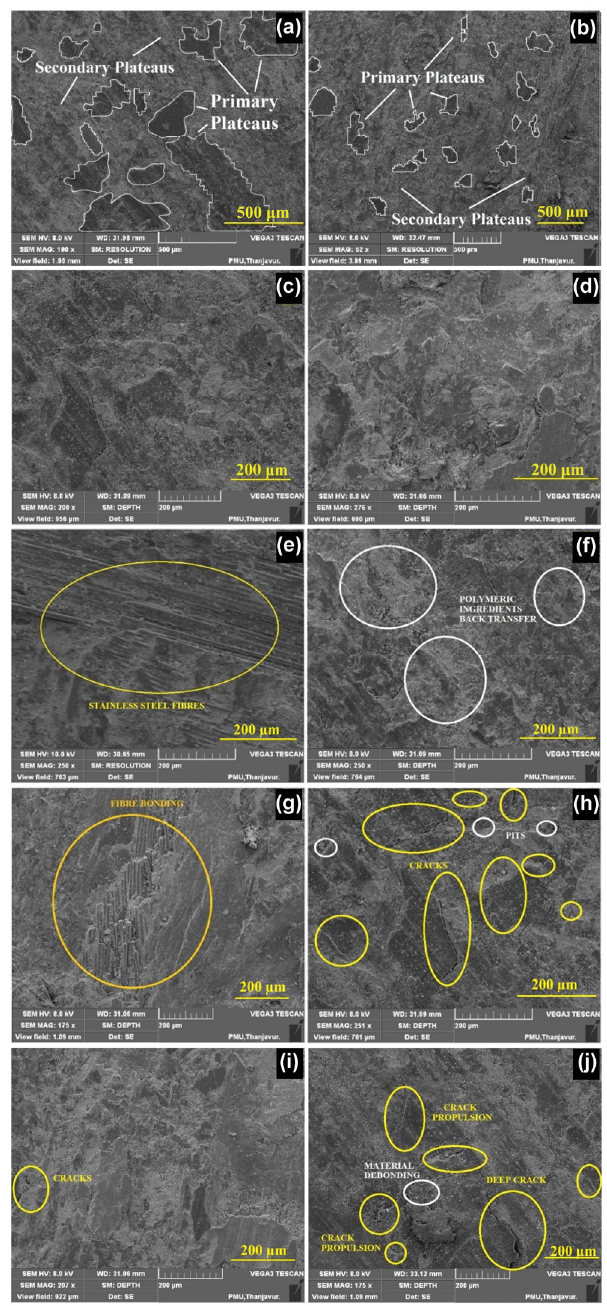
Fig. 11 SEM images of (a) plateaus formation of the FM02 dyno tested composites, (b) plateaus formation of the FM01 dyno tested composites, (c) plateaus formation of the FM02 dyno tested composites closure view, (d) plateaus formation of the FM01 dyno tested composites closure view, (e) fibers in the direction of sliding of the FM02 composite, (f) more back transfer of polymeric ingredients in the FM01 composite, (g) firm bonding of stainless steel fiber in the FM02 composite, (h) crack initialization and spalling pits of the FM01 composite, (i) less crack in the FM02 composite, and (j) deep crack propulsion and material debonding in the FM01